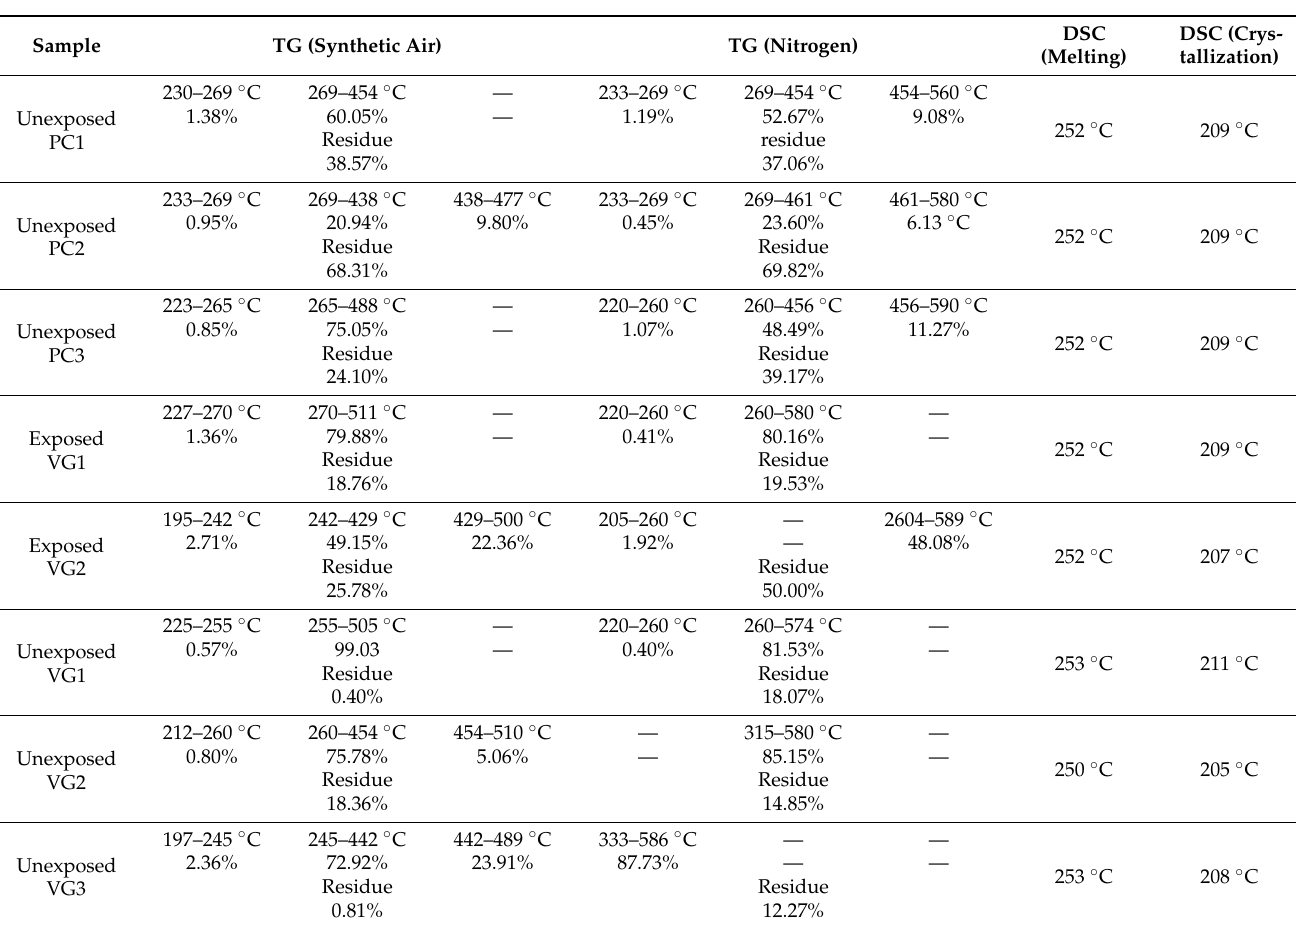
Table 6. Temperature intervals ( ◦ C) obtained from TG curves in synthetic air and nitrogen and DSC in synthetic air, with a heat flow rate of 10 ◦ C.min − 1